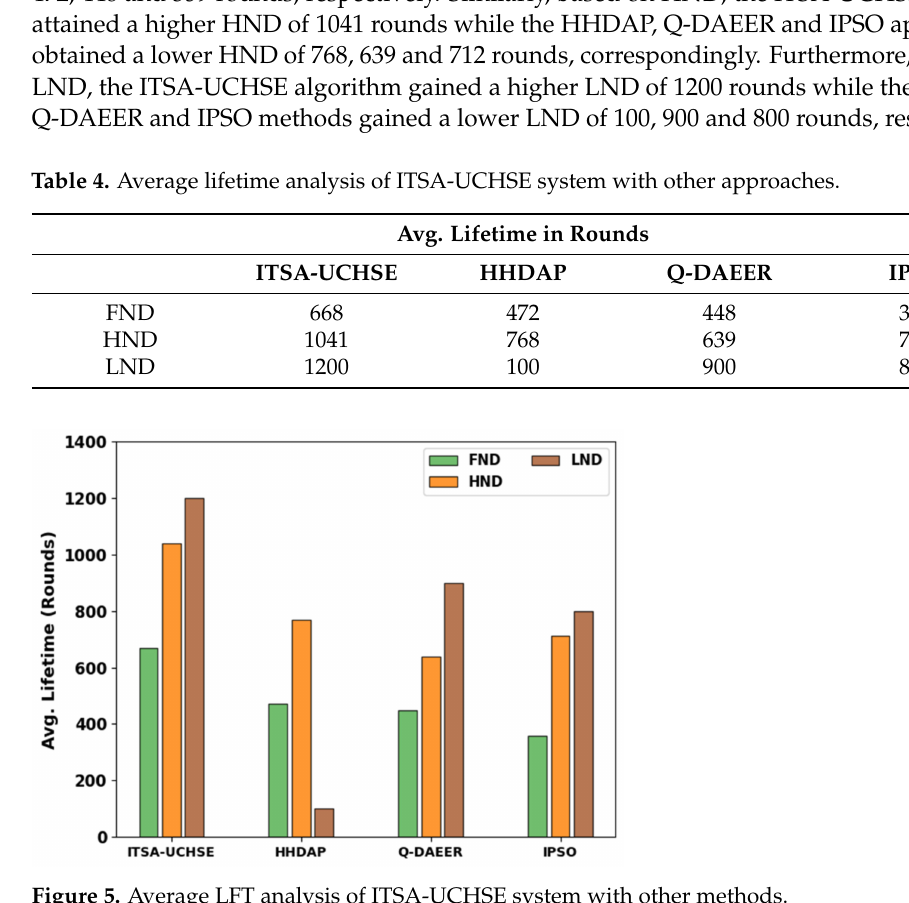
Figure 5. Average LFT analysis of ITSA-UCHSE system with other methods.